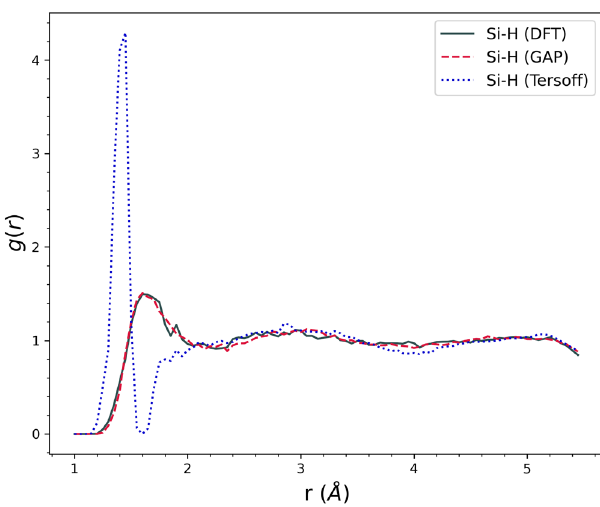
Fig. 7 Si – H pair correlation function in liquid Si:H. The liquid Si – H RDF computed with the Si – H GAP and with DFT are barely distinguishable, while both differ from the Tersoff-computed RDF markedly. These results further demonstrate the quality of ML-based potentials such as the Si – H